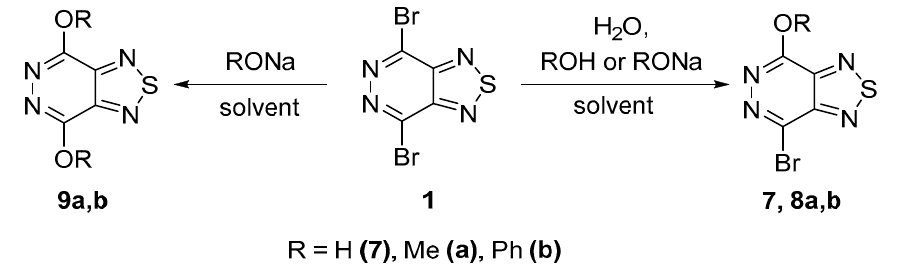
Table 1. Reaction of 4,7-dibromo[1,2,5]thiadiazolo[3,4- d ]pyridazine 1 with O -nucleophiles.